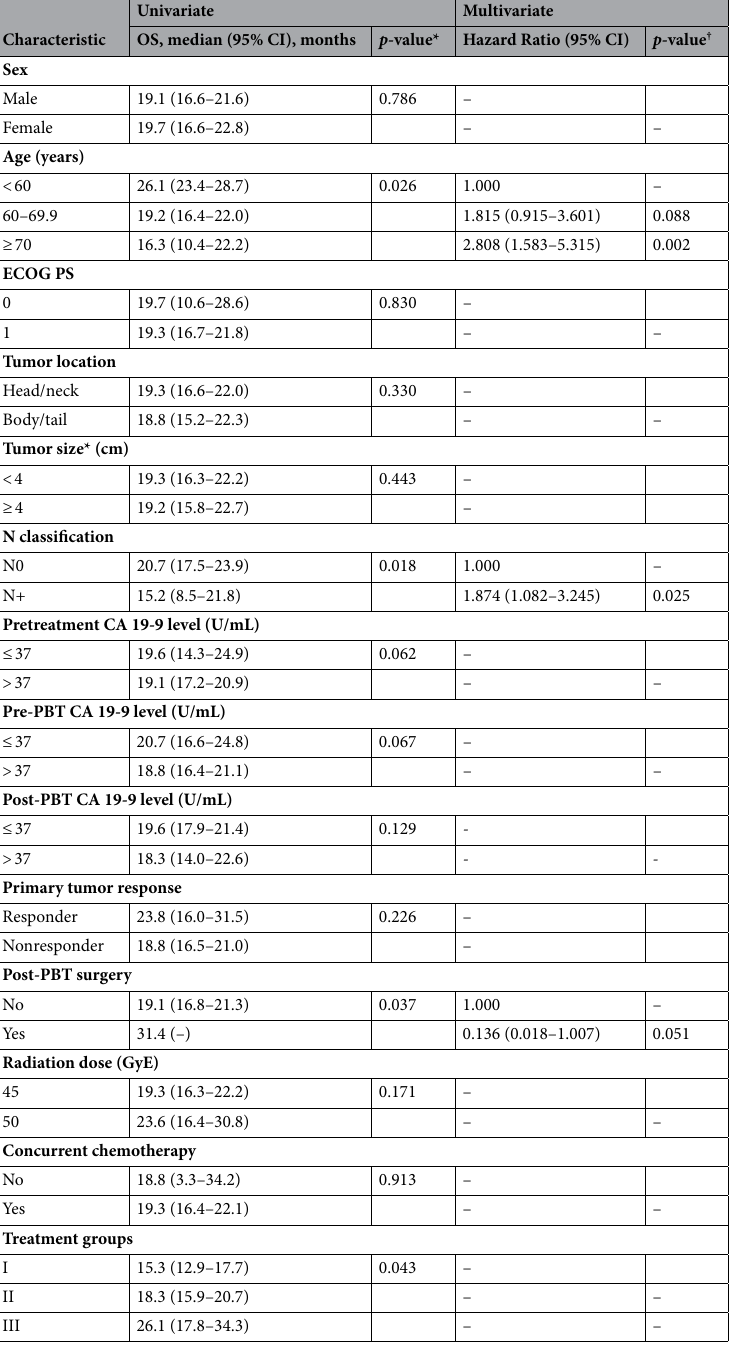
Table 2. Univariate analysis of clinical characteristics associated with overall survival (OS). Responder complete or partial response, Nonresponder stable disease or progressive disease, CI confidence interval, and others are the same as in Table 1. *Log rank test. † Cox proportional hazards